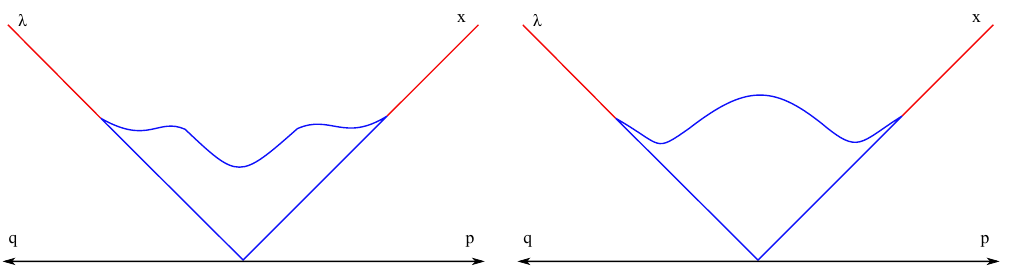
Figure 4 . In the left figure we depict a typical Young diagram in the unsaturated phase (for larger ξ eff ) and in the right one a typical Young diagram in the saturated phase (for smaller ξ eff ). The shape can be understood by considering the slope function Ω 0 ( z ) = 1 − 2 N ( z ) , for z ≥ 0 (it becomes one when there is no density and minus one when there is saturation). In the case of exactly zero µ that we analyse, the shape at p = q = z = 0 is continuous but has a cusp (that we have smoothed out in order to show the effect of including the singlet contribution in N ( z ) for a small non-zero µ